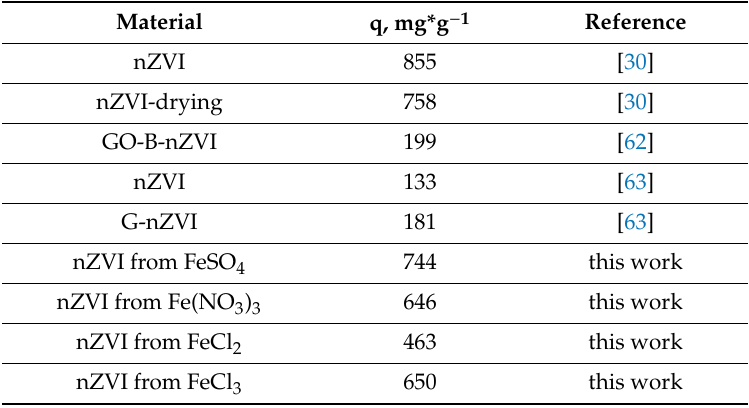
Figure 7. Pb 2+ ions removal efficiency by the nZVI samples produced from different salts. Table 2. Comparison of the lead removal capacity